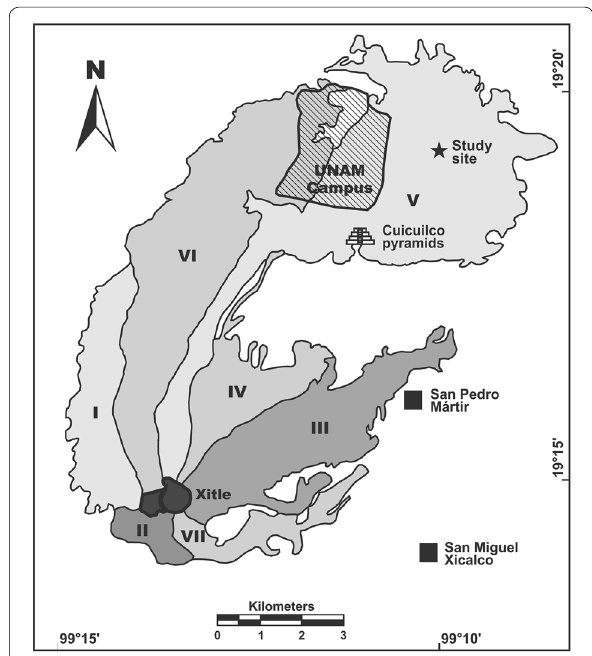
Fig. 1 Location map of Xitle volcano and the spatial distribution of its different lava flows (modified from Delgado‑Granados et al.